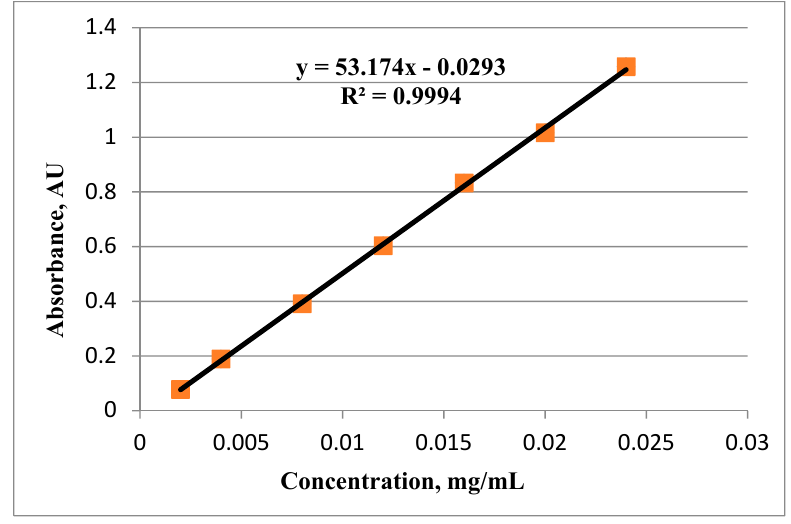
Figure 3. Standard calibration curve of ursolic acid standard solutions.